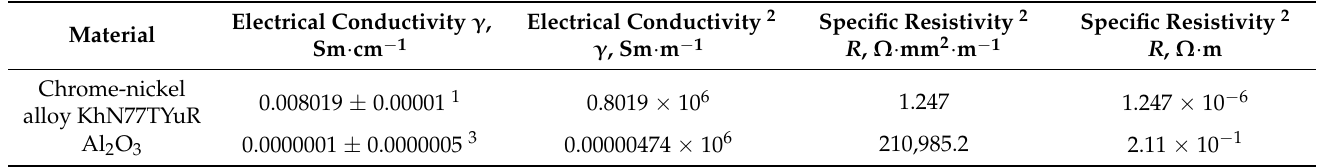
Table 9. Electrical properties of the developed coating at +20 ◦ C.